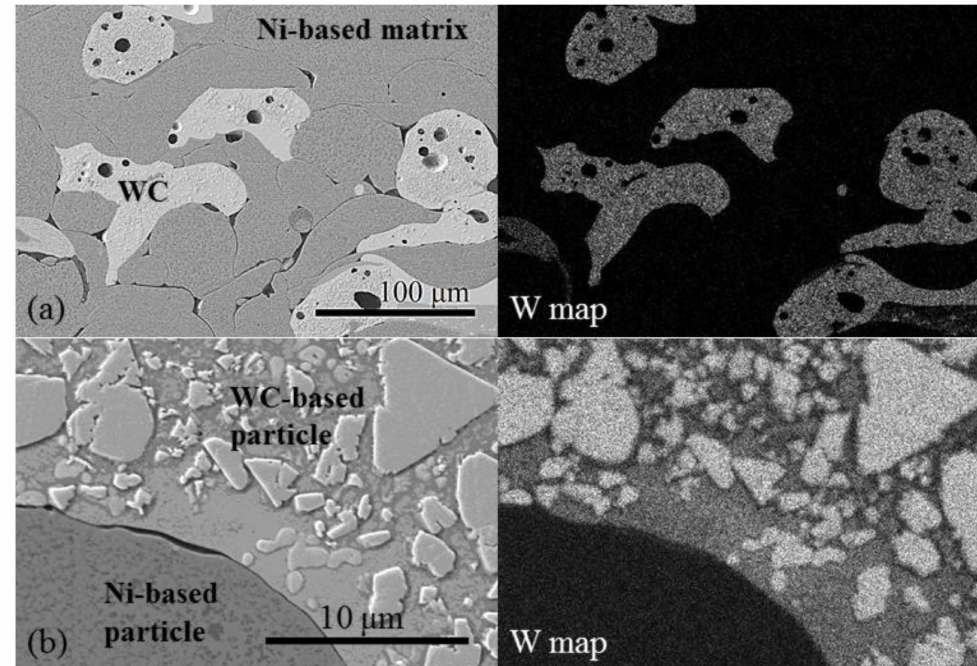
Figure 4. SEM micrographs of the as-sprayed coating (R0) at different magnifications, and tungsten (W) distribution maps obtained with EDS: ( a ) coating general view at a lower magnification and map of W distribution; ( b ) morphology of the WC-based particle at a higher magnification and map of W distribution; lighter areas correspond to a higher element